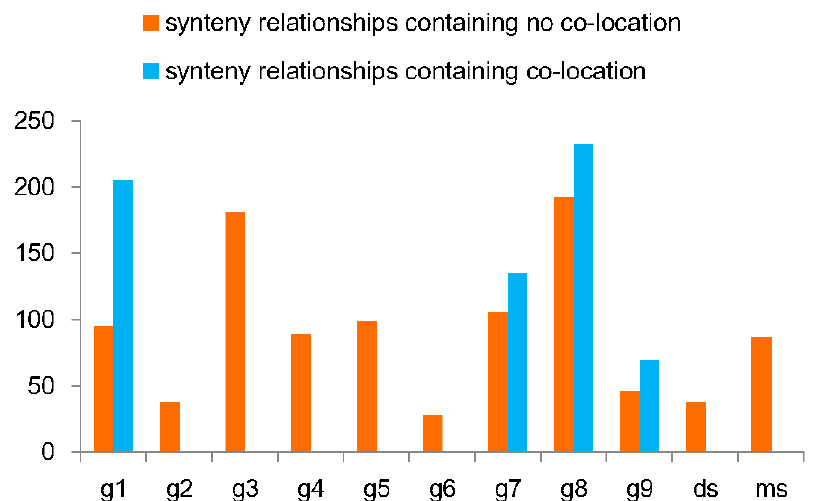
Figure 5. The number of synteny relationships between the SBP group and miR156. The orange bar refers to the number of synteny relationships without co-locations, while the blue bar refers to the number of synteny relationships with co-locations.